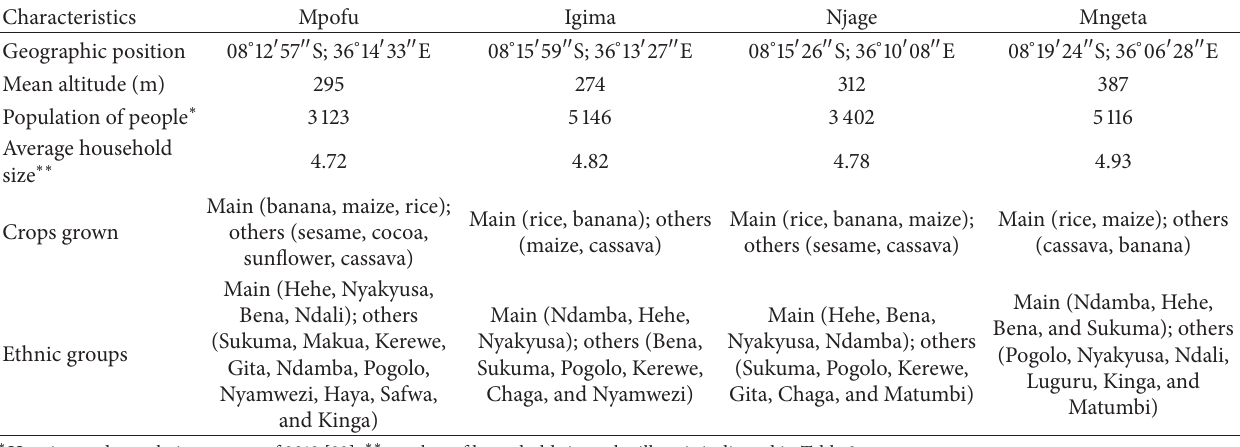
Table 1: Some physical and demographic characteristics of the study area.